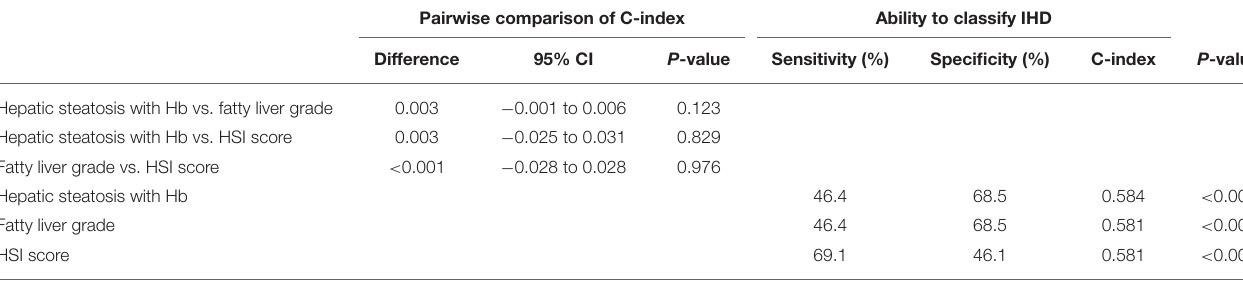
TABLE 3 | Hepatic steatosis with hemoglobin vs. fatty liver grades and HIS score for predicting ischemic heart disease. Pairwise comparison of C-index Ability to classify IHD Difference 95% CI P -value Sensitivity (%) Specificity (%) C-index P -value Hepatic steatosis with Hb vs. fatty liver grade 0.003 − 0.001 to 0.006 0.123 Hepatic steatosis with Hb vs. HSI score 0.003 − 0.025 to 0.031